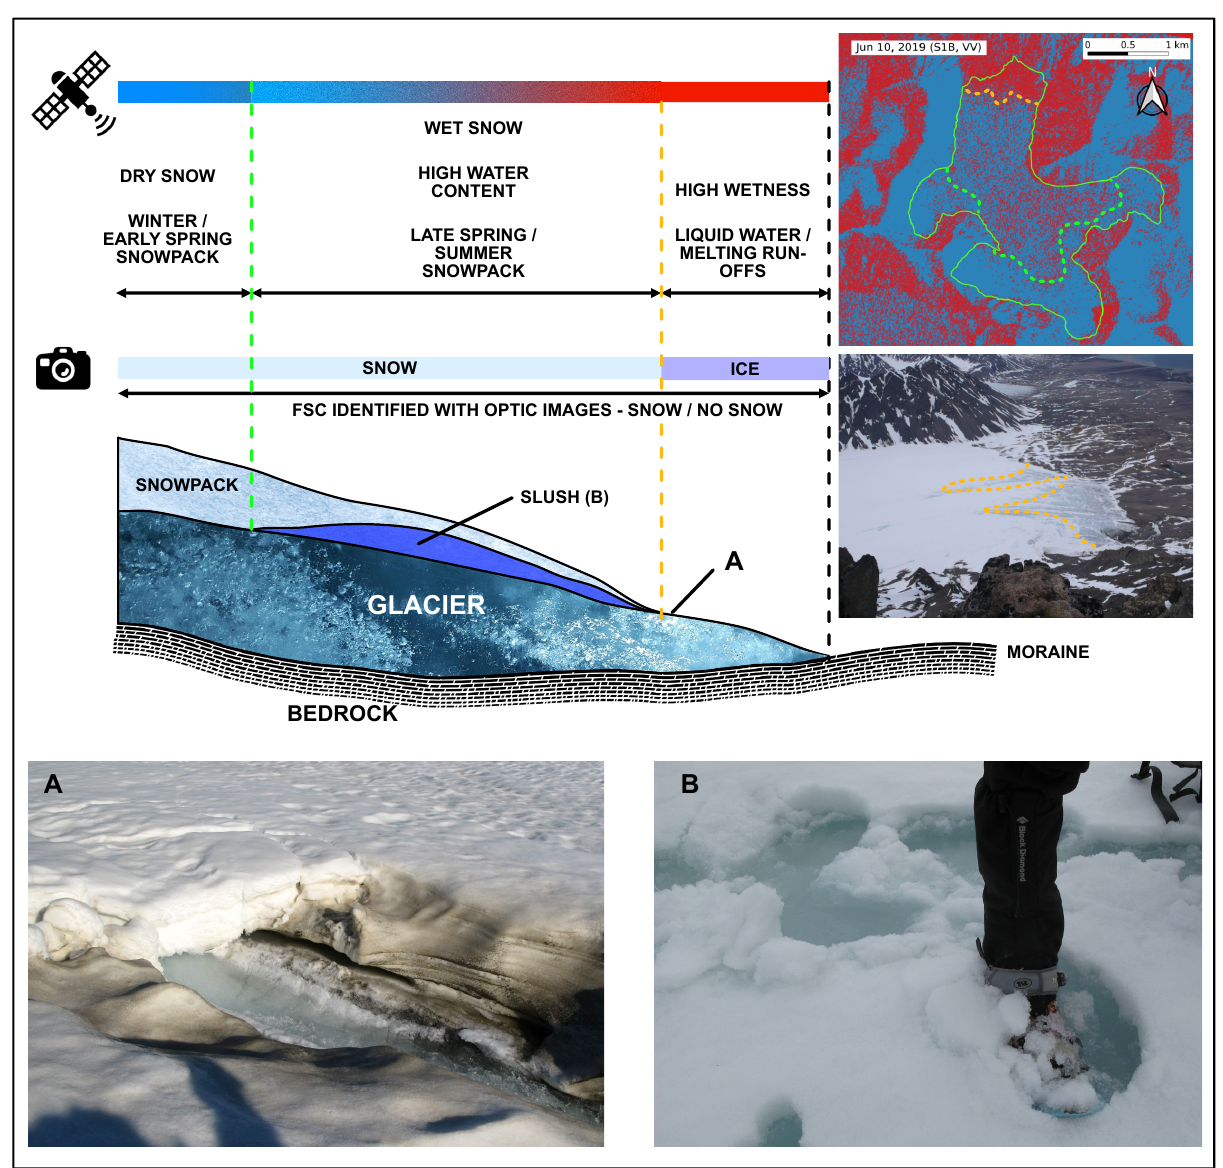
Figure 9. ( A ) Run-offs at the interface between the glacier surface and the snowpack: the water system is active with significant outflows due to the snowpack melting, while the snowpack depth is several centimeters deep. ( B ) When the snowpack is water-saturated, it turns into water immediately, with only a small grounding pressure when walking on the snow. This phenomenon is know as “snow swamp” and gives a significant quantity of running water all at once. This short duration state of transition is clearly identifiable on RADAR images. In all images, blue indicate highly microwave reflective areas and red is highly absorbing (low reflection)